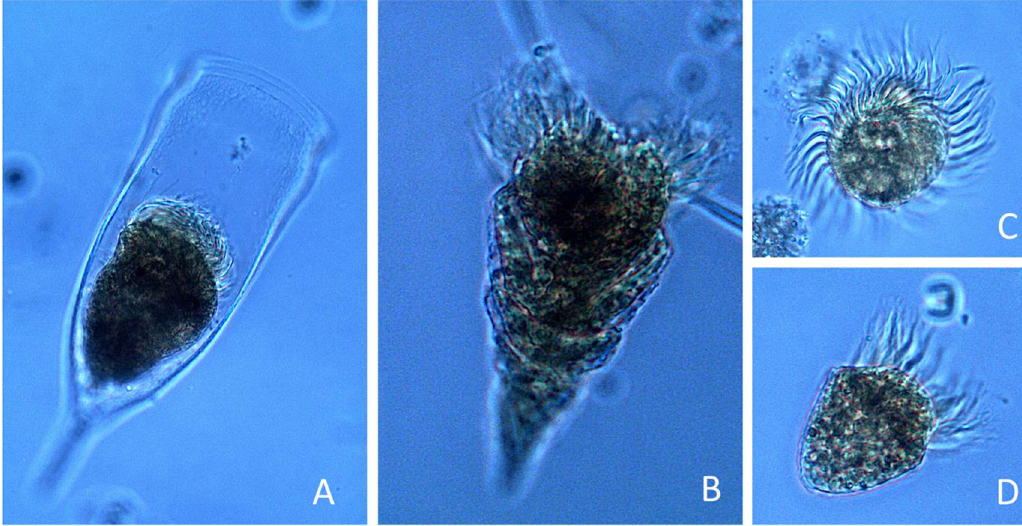
Figure 7. Micrographs of ciliates (genera) recorded in the net-haul samples: ( A ) Favella ; ( B ) Laboea ; ( C ) Leegaardiella ; ( D ) Strombidium.